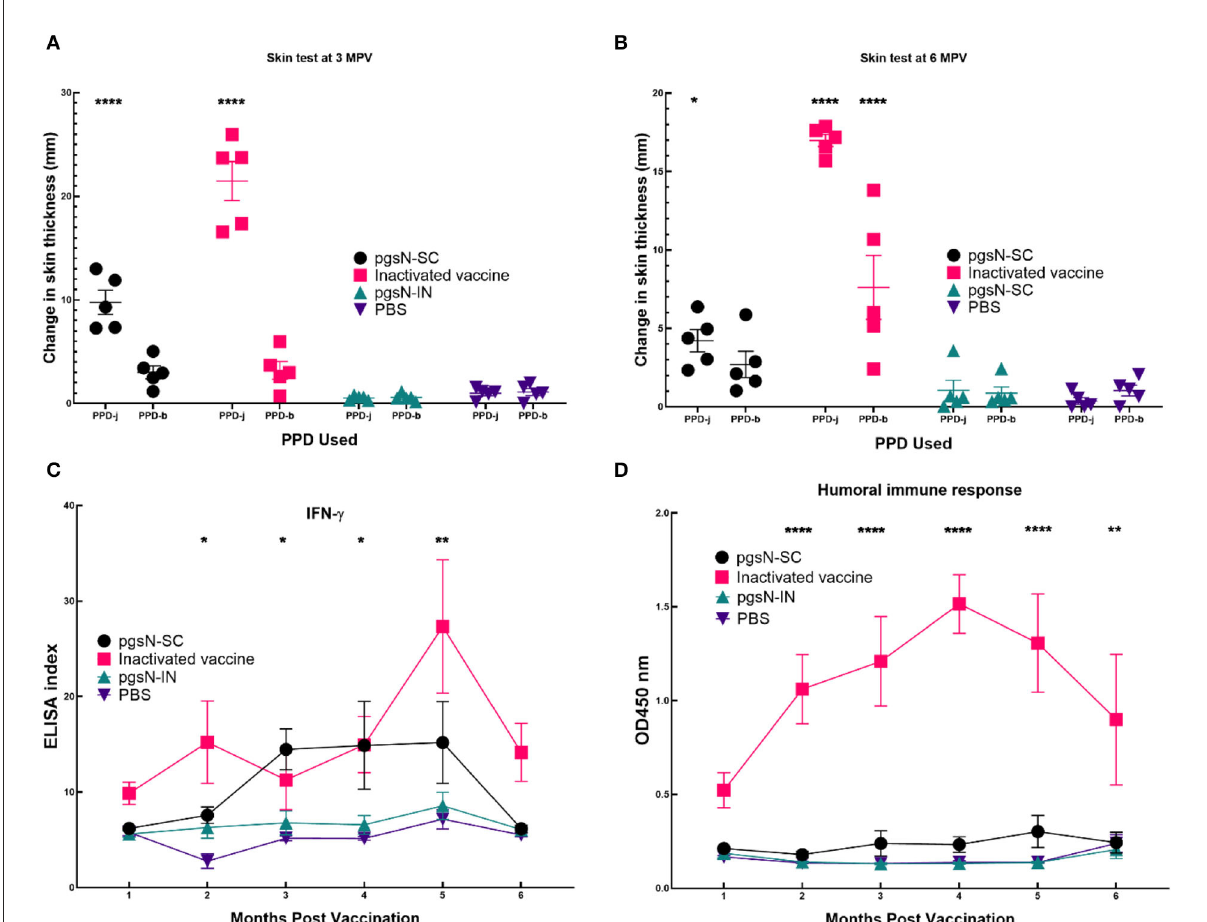
FIGURE6 Immune responses to vaccination. Evaluation of cell Mediated Immunity as measured by reaction to intradermal skin test at (A) 3 and (B) 6 months post vaccination (5 animals/group). Each point in (A, B) represents one animal’s difference in skin thickness at the PPD site of injection at 0 and 72h post injection. Purified protein derivative from both M. paratuberculosis (PPD-j) and M. bovis (PPD-b) were used to inject animals. Bars represent the standard error measurements for each group. (C) Measurement of IFN- γ levels in vaccinated goat groups. Peripheral blood mononuclear cells (PBMCs) were isolated from whole blood and stimulated with PPD-j for 72h. IFN- γ levels in culture supernatants were determined using a Bovigam ELISA kit. Data are expressed as an ELISA index, with error bars represent the standard error. (D) Humoral Immune responses as measured by commercial ELISA from sera collected from immunized animals. Asterisks indicate statistical significance between each group immunized with subcutaneous injection compared to PBS using ANOVA. *, p -value < 0.05; **, p -value < 0.01; ****, p -value < 0.0001. In (D) only inactivated vaccine gave significant